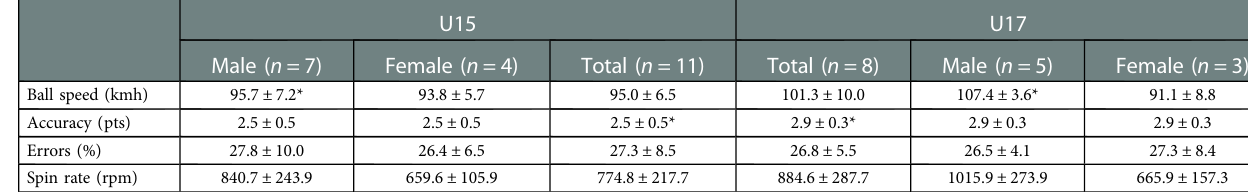
TABLE 2 Descriptive statistics of technical skills (mean±SD) and differences between talented tennis players U15 and